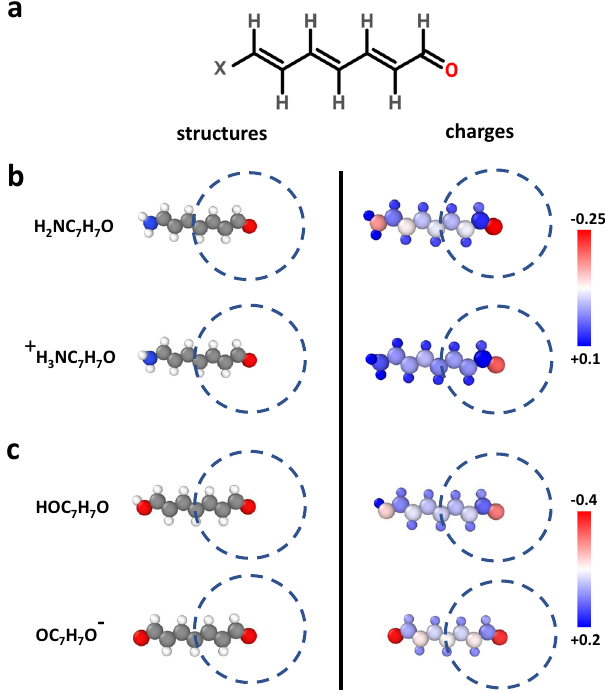
Fig. 1 Illustration of long-range charge transfer in a molecular system. In a the investigated molecule XC 7 H 7 O with X representing different functional groups is shown. b The protonation of NH 2 group yields a positive ion and result in different charges of the oxygen atom as can be seen in the plot of the DFT atomic partial charges on the right side. In both cases, the local chemical environments of the oxygen atoms are identical within the cutoff spheres shown as dashed circles. c The deprotonation of the OH group yields a negative ion and both oxygen atoms become chemically equivalent with the nearly same negative partial charge. Also in this case the chemical environment of the right oxygen atom is identical to the neutral molecule although the charge distribution differs. All these cases cannot be correctly described by local methods like 2G and 3G ML potentials. The structure visualization for non-periodic systems was carried out using Ovito 66